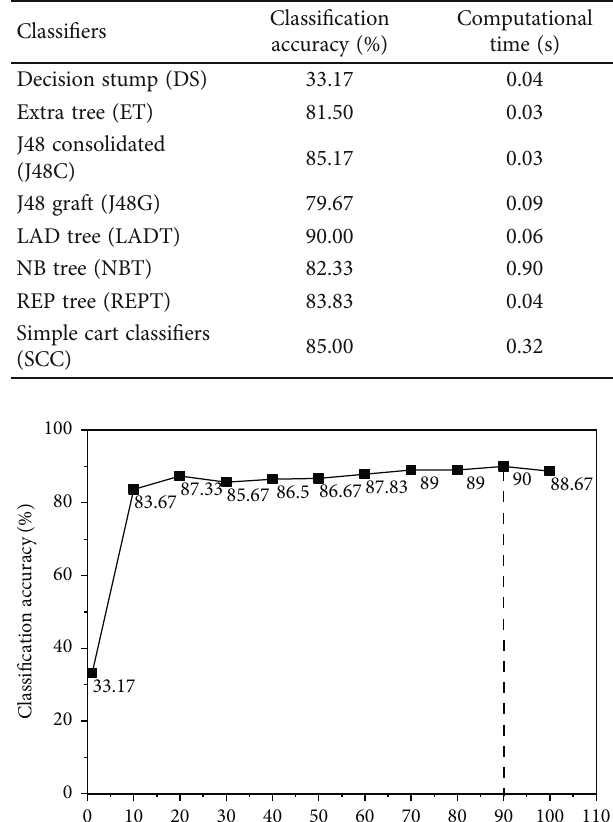
Table 4: Classi fi ers accuracy.